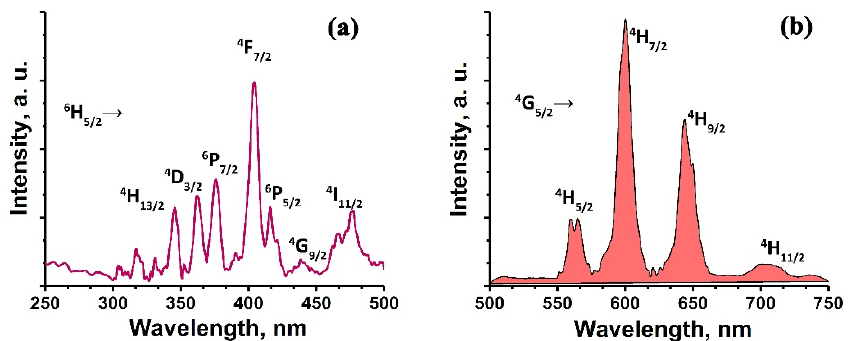
Figure 5. ( a ) PLE ( λ em = 602 nm) and ( b ) PL ( λ ex = 404 nm) spectra for Ca 9 Gd 0.9 Sm 0.1 (PO 4 ) 7 . The PLE spectrum of Gd 0.9 Tm 0.1 , monitored at λ em = 477 nm, is presented in Figure 6a. The spectrum demonstrates an expressed band at 356 nm, corresponding to 3 H 6 → 1 D 2 transition within Tm 3+ . The onset observed below 300 nm might be attributed to the defect- related absorption. The characteristic emission line, corresponding to 4 f– 4 f transition within Tm 3+ is observed at PL spectrum (Figure 6b). This band is located at 455 nm and is due to 1 D 2 → 3 F 4 transition [14,24,25].